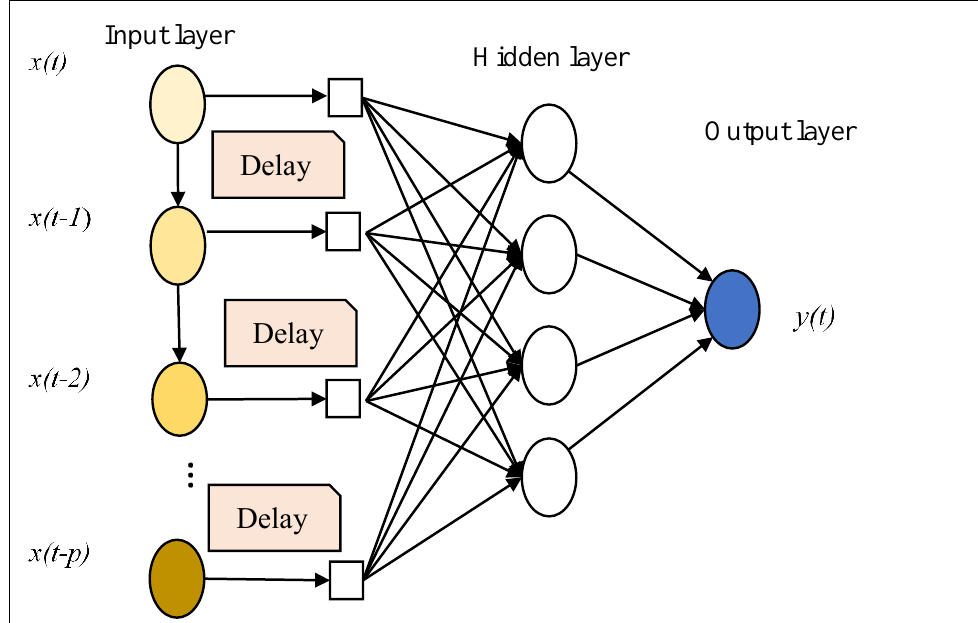
Figure 1. The architecture of a time delay neural network (TDNN).